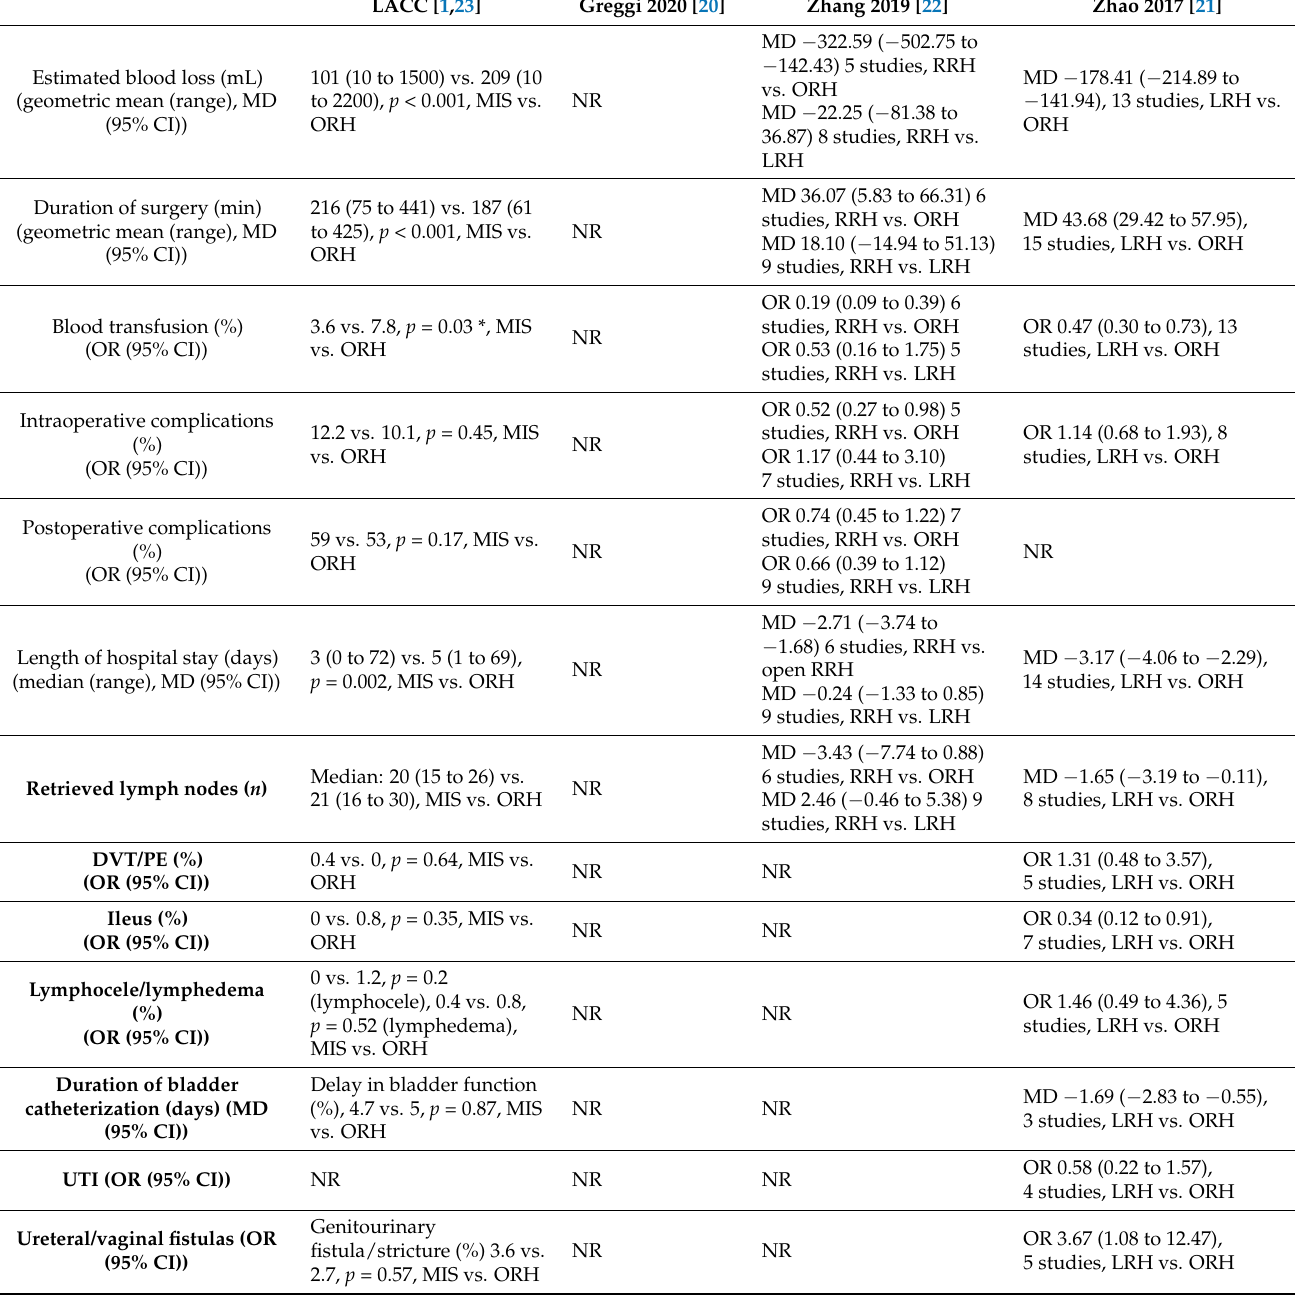
Table 5. Intra and perioperative outcomes for the LACC trial and the